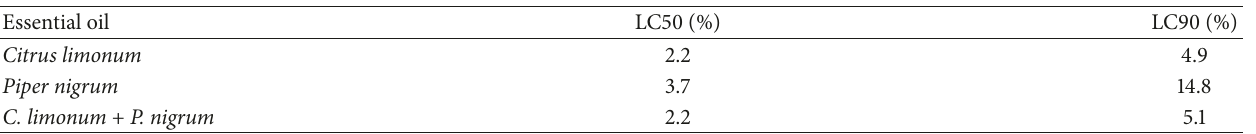
Table 2: LC50 and LC90 (%) obtained for the engorged female of the essential oils of Citrus limonum , Piper nigrum, and their combination on R. microplus